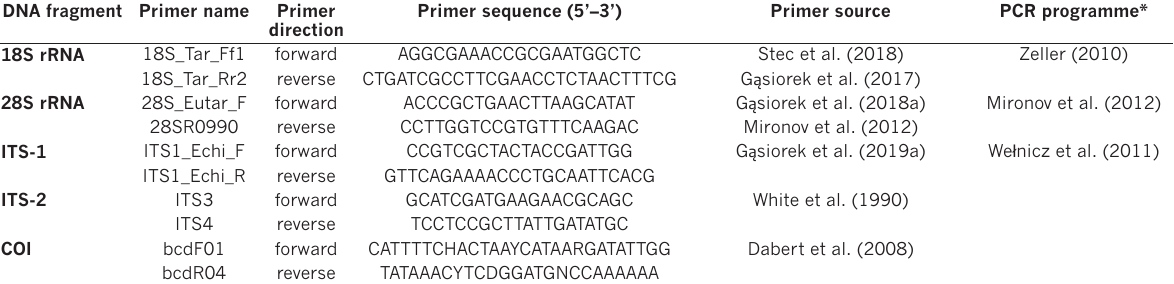
Table 1. Primers and references for specific protocols for amplification of the five DNA fragments sequenced in the study. DNA fragment Primer name